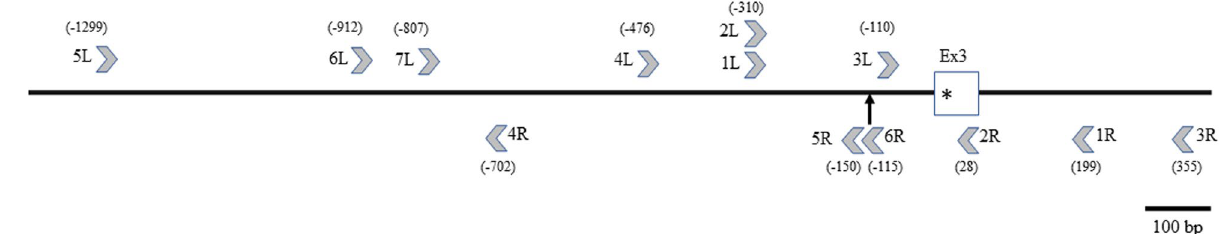
Figure 1. Primer location. Grey arrows show the relative position of forward (up) and reverse (down) primers used to localize the Insertion in the PNPLA3 gene. Numbers in parentheses show the position of primers relative to the p.I148M variant. White box indicates the third exon; asterisk indicates the location of p.I148M variant (position 5043 in NG_008631.1, corresponding to 43,928,847 in GRCh38.p13 assembly, accession NC_000022.11); black vertical arrow indicates the location of the Insertion (position 4921/4922 and 43,928,725/6 in NG_008631.1 and NC_000022.11,